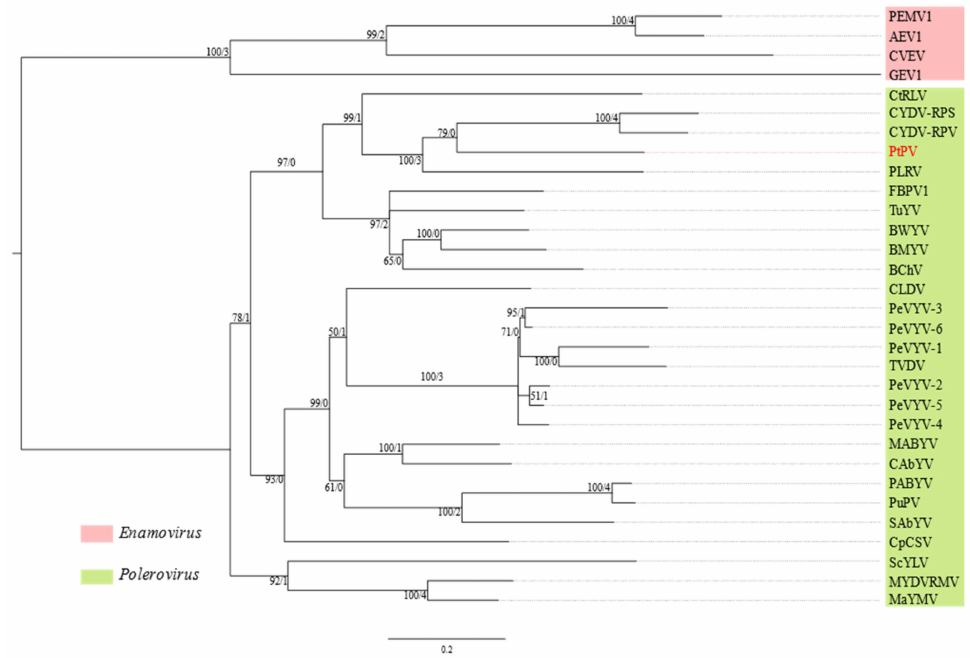
Figure 7. Maximum likelihood reconstruction of the phylogeny of poleroviruses based on con- catenated codon sequence alignments of the conserved regions of four genes (serine proteinase, RNA-dependent RNA polymerase, capsid protein (P3) and the domain at the C-terminus of P3 in P3–P5 readthrough protein). The acronym in red font corresponds to the virus isolate discovered in this study (Table 1) and the other virus acronyms are defined in Table S7. The numbers to the left of the slash next to the branches are non-parametric bootstrap values based on 1000 replicates; the numbers to the right of the slash are the number of decisive gene trees (4 at maximum) supporting the branch. The nucleotide substitution models are listed in Table